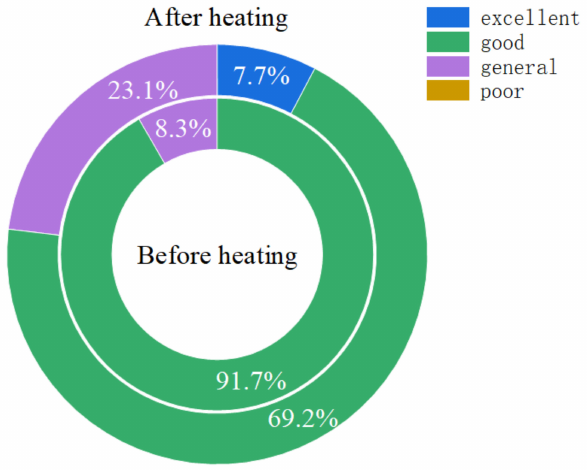
Figure 20. IAQ evaluation